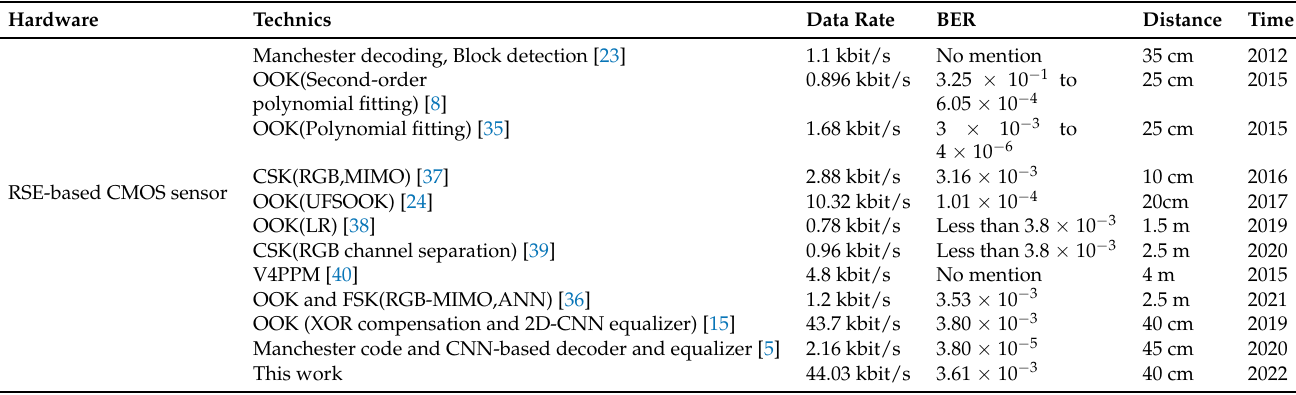
Table 2. Performance